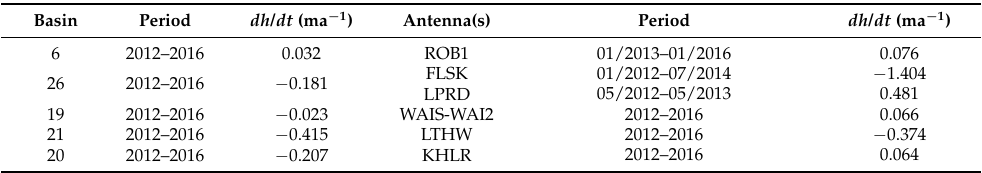
Table 4. Comparison between the new Antarctic 25 year elevation trends on the left and the results of this study on the right.